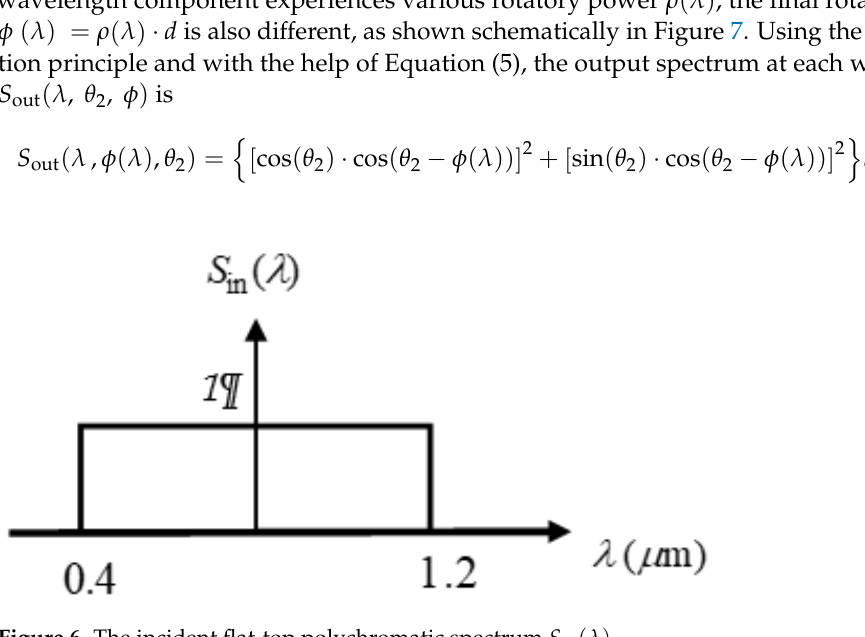
( ) S  . Figure 6. The incident flat-top polychromatic spectrum S in ( λ ) in